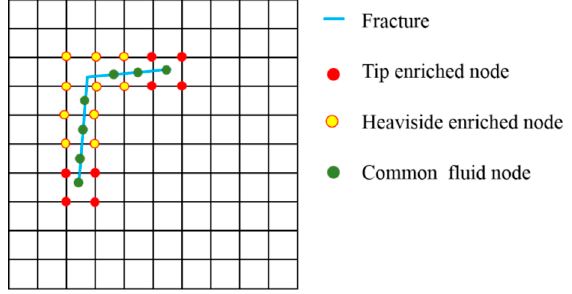
Figure 1. Schematic of enrich nodes and common fluid nodes (pore-pressure nodes within a fracture).